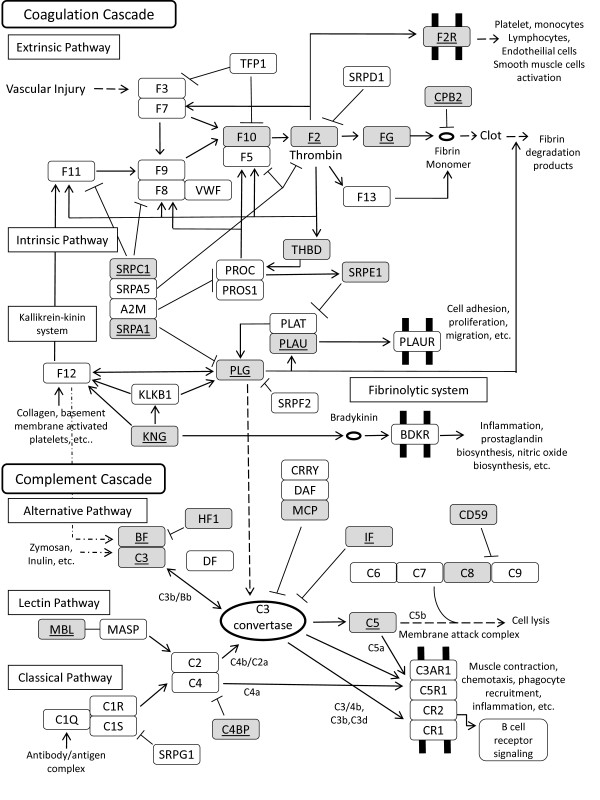
Complement/Coagulation pathway activation. Adaptation of KEGG Complement and Coagulation pathways. Shaded pathway members were found significant by low stringency filtering of data set while members underlined were found only in the high stringency results.